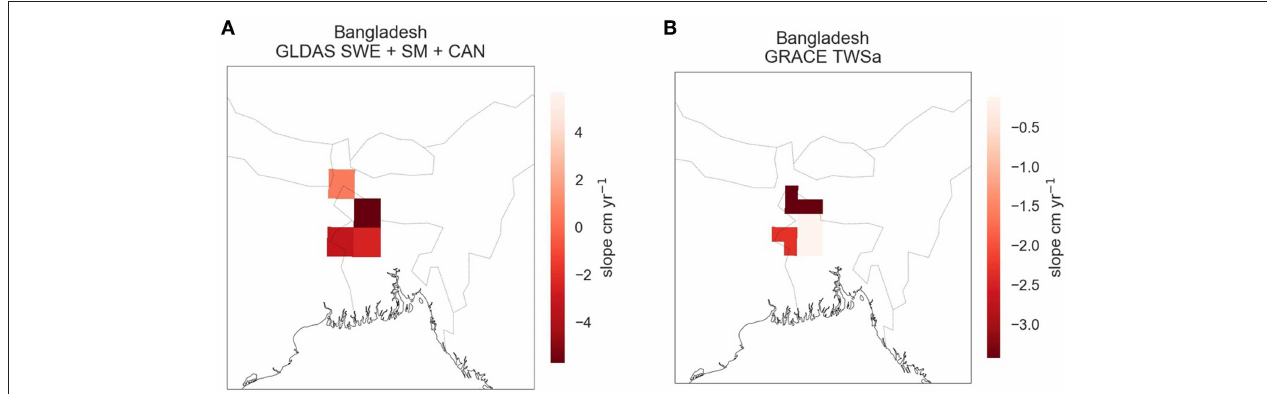
FIGURE 3 | Changes in water storage represented as the slope from 2002 to 2017 for the sum of GLDAS water storage components (A) and GRACE total water storage (B) . The plots demonstrate the difference in spatial resolution of the two datasets (GLDAS 1 ◦ and GRACE 0.5 ◦ ).